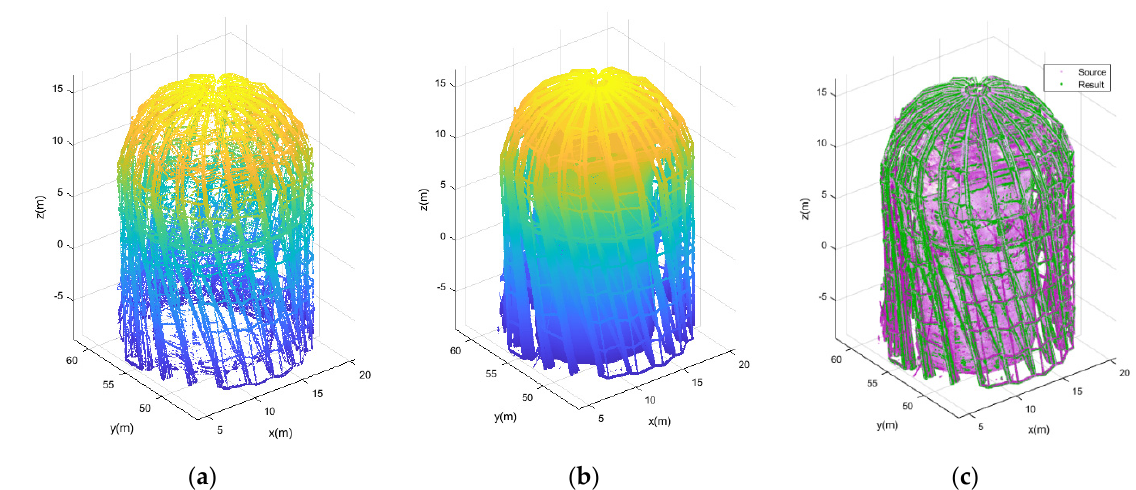
Figure 16. Structure detection results: ( a ) detected edges (results), ( b ) source cloud, ( c ) composite view (source point cloud in magenta, edges (results) in green).